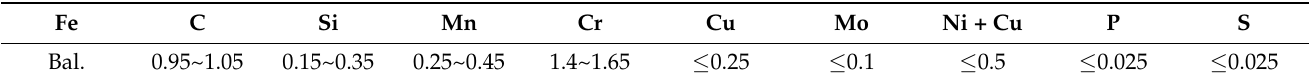
Figure 8. Heat transfer boundaries: ( a ) axial symmetry heat transfer ; ( b ) orthogonal symmetrical heat transfer ; ( c ) external orthogonal symmetrical and internal axial symmetry heat transfer.